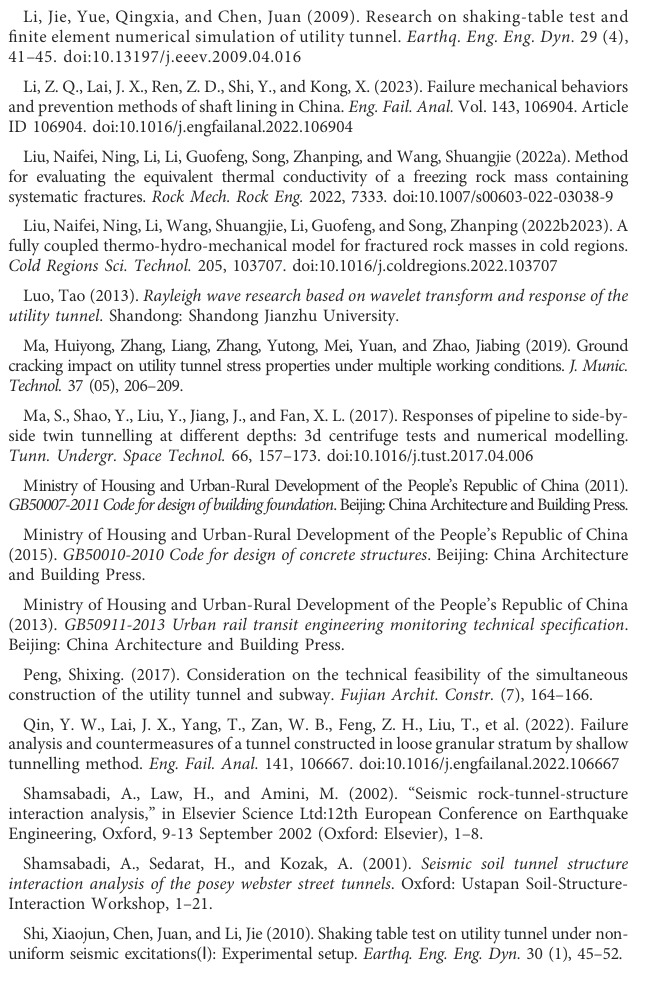
table. J. Harbin Inst. Technol. (6), 1 –